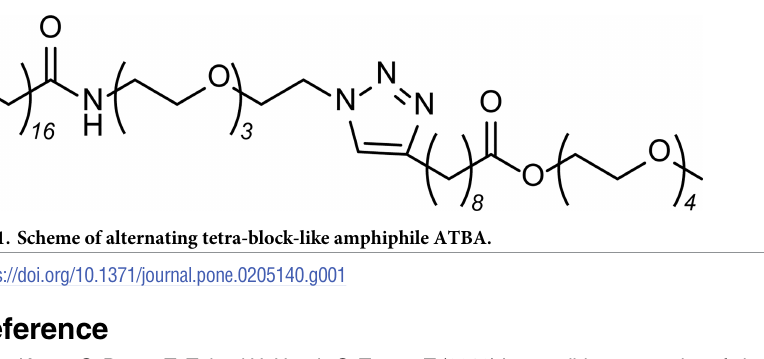
Fig 1 is incorrect. The text box with numbers “18230006” should not appear in the figure. The publisher apologizes for the error. Please see the corrected Fig 1 here.